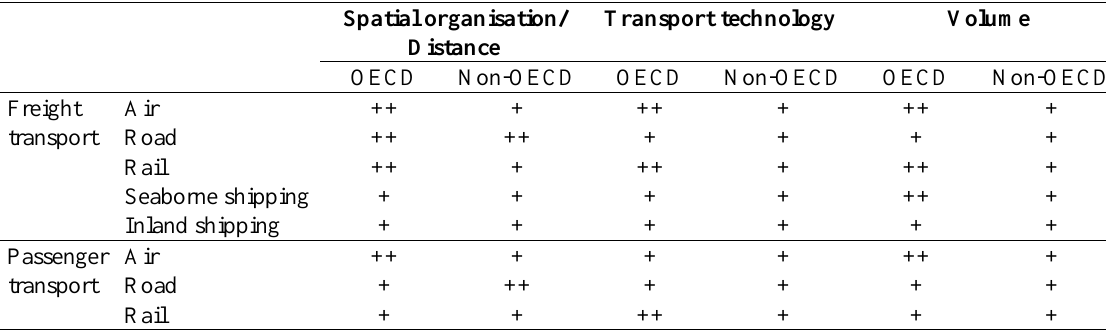
Table 2. Scenario 2: